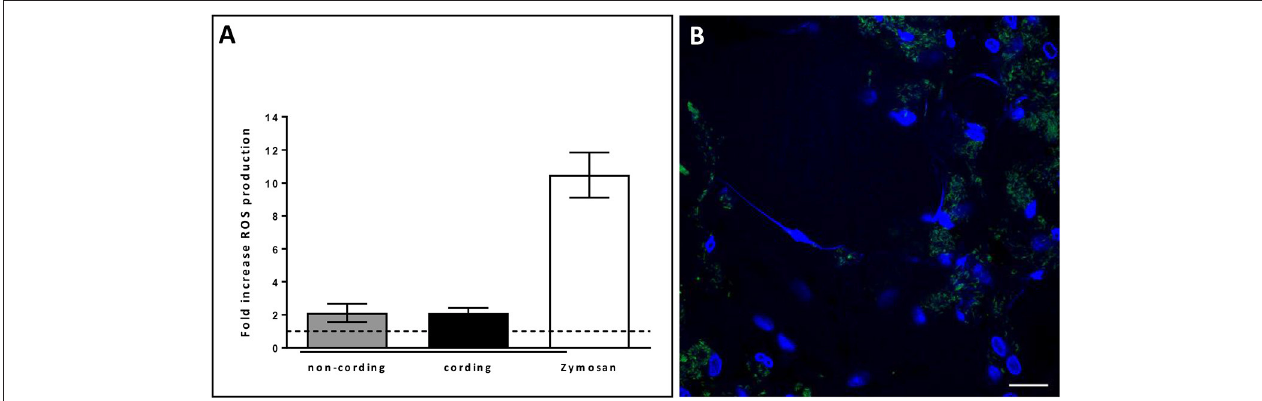
FIGURE 5 | METs formation in human macrophages is independent of ROS. (A) Cording and non-cording bacteria induce ROS-production in macrophages to a similar extent. Zymosan was used as a positive control. Mean values ± SEM from hMDMs from 3 donors (measured in duplicates) are shown. (B) DPI-inhibition of ROS-production did not inhibit METs-release in hMDMs infected with the cording phenotype of H37Rv. Cells were stained with DAPI after 24 h of infection. Bar: 20 µ m.